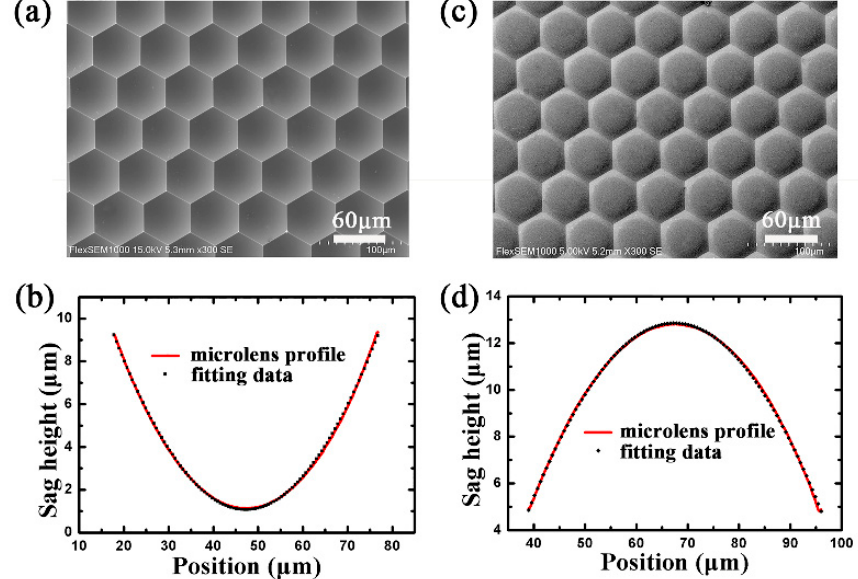
Figure 3. ( a ) SEM image of master mold. ( b ) Cross-sectional profile of a concave microlens mold. ( c ) SEM image of ChG convex microlenses. ( d ) Cross-sectional profile of ChG convex microlenses.